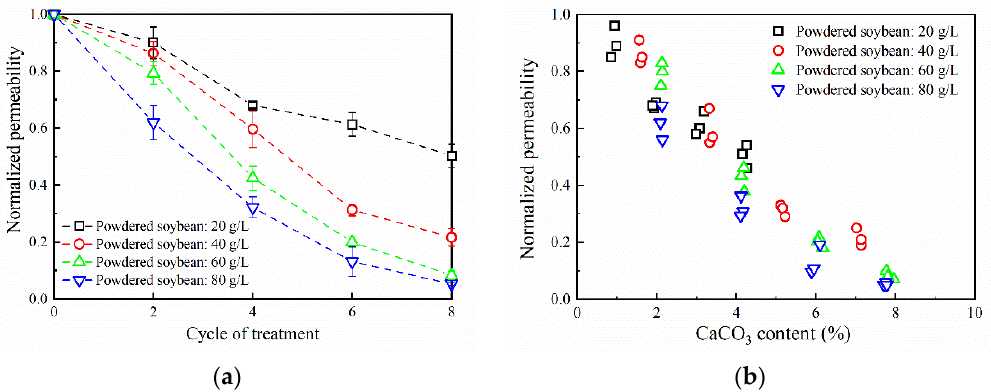
Figure 14. Effect of powdered soybean concentration on the normalized permeability as a function of ( a ) cycle of treatment and ( b ) CaCO 3 content. ( a ) cycle of treatment and ( b ) CaCO 3